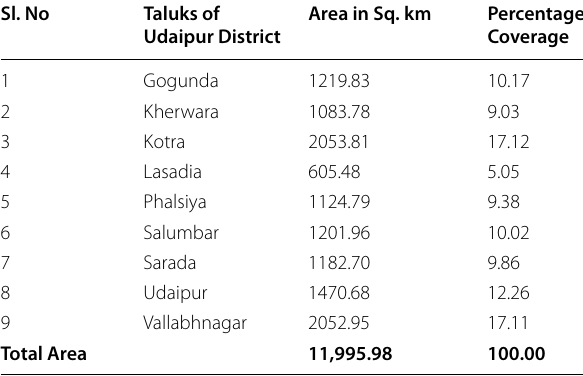
Table 4 Area of the individual taluk Sl.